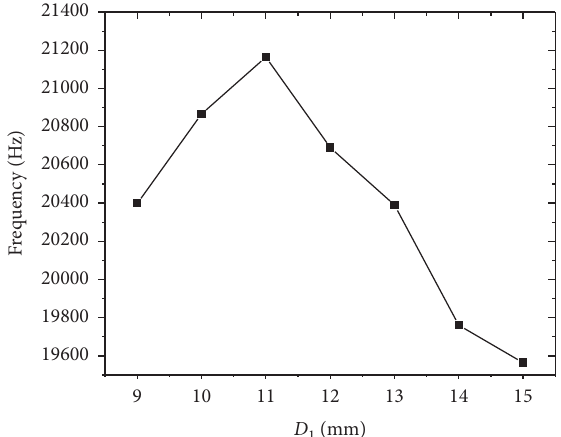
Figure 9: The effect of the diameter D the compound horn on vibration frequency.